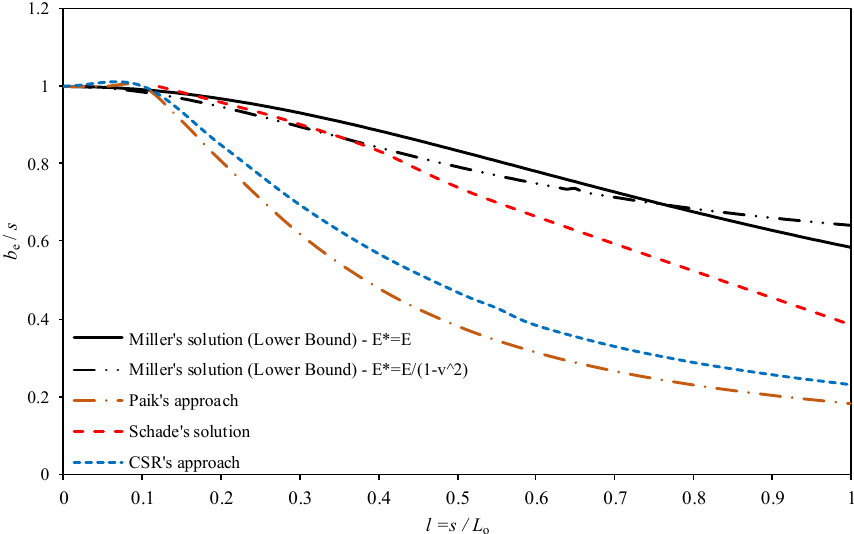
Figure 4. Comparison of effective width concept for the four considered cases.